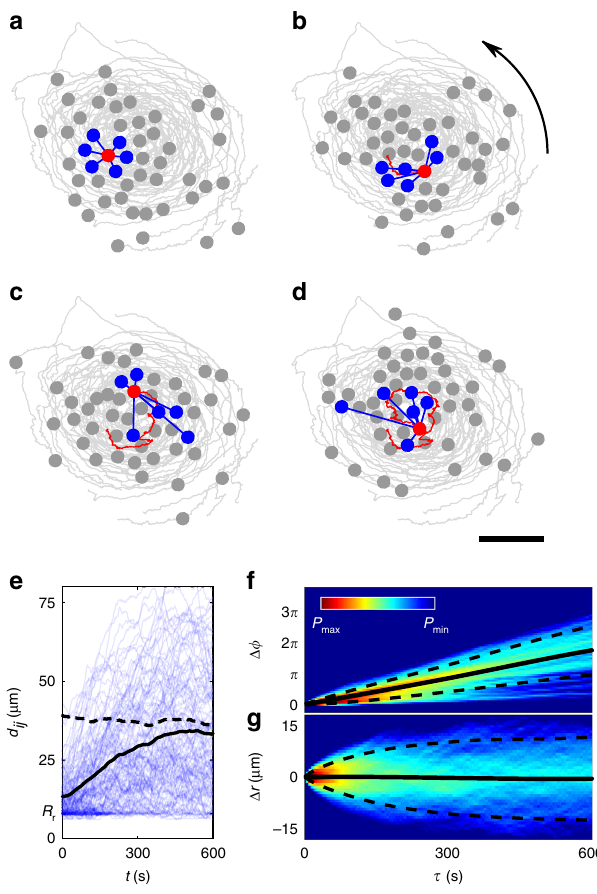
Fig. 2 Temporal decay of next-neighbour correlations. a – d Snapshots of the positions of a single AP (red) and its original ( t = 0 s) nearest neighbours (blue) at times t = [0, 100, 300 and 600] s. Grey lines correspond to trajectories over 600 s each. The scale bar is 30 μ m. e Time dependence of all distances to original ( t = 0 s) next neighbours (blue lines). The mean value of these curves (solid line) converges to the average of all possible pair distances (dashed line). The lower limit R r indicates the repulsion range between APs. f , g Time-dependent probability distributions of the angular and radial AP displacements (both measured relative to the swirl centre). From the slope in c , one obtains a swirl ’ s revolution time of about 600 s. Dashed lines show the standard deviation. All data are obtained for α = 360°, Δ = 67.5°, R p = ∞ .